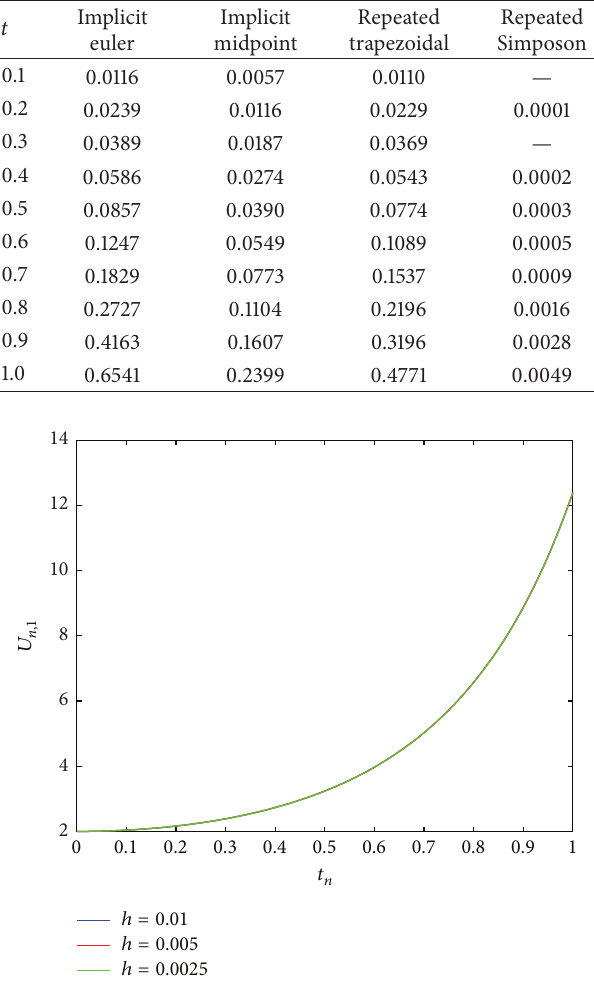
Figure 5: The solution of (48) by the repeated Simpson’s